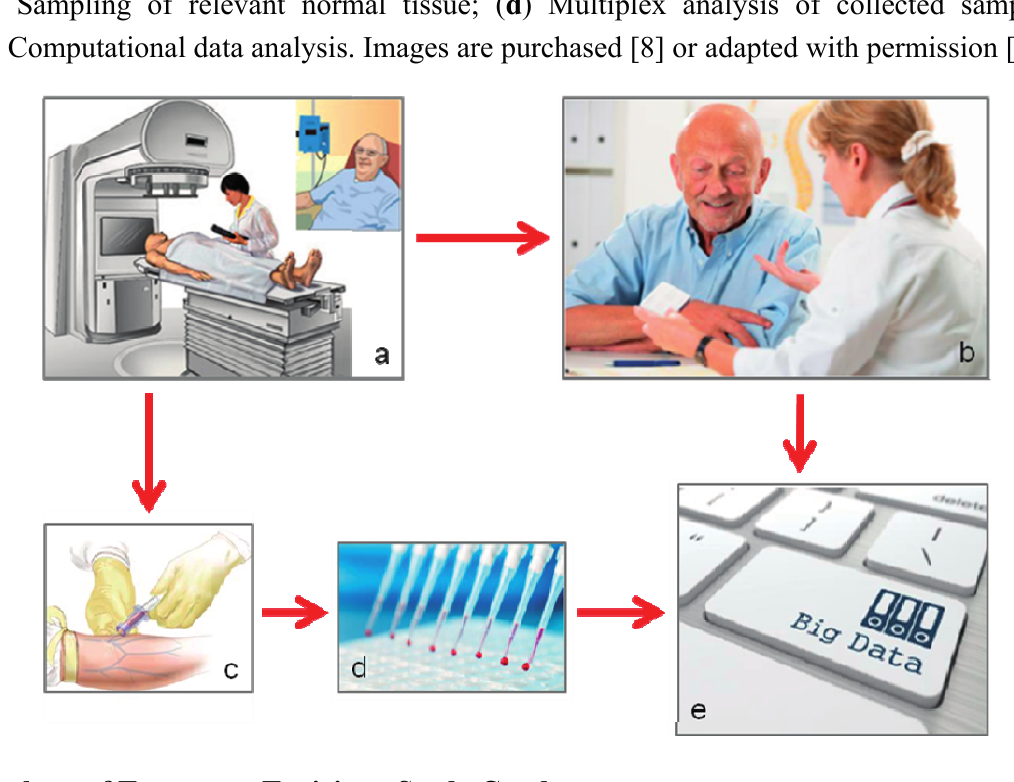
Figure 1. Pathway of study conduct in molecular portraying of clinical toxicity